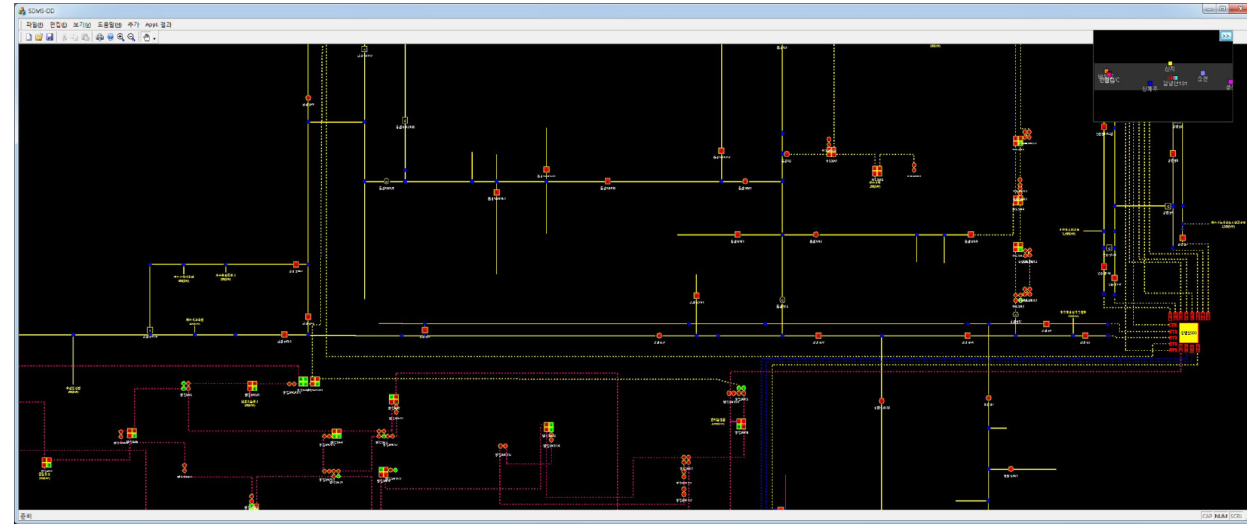
Figure 13. Test system for case studies (Jeju Island).